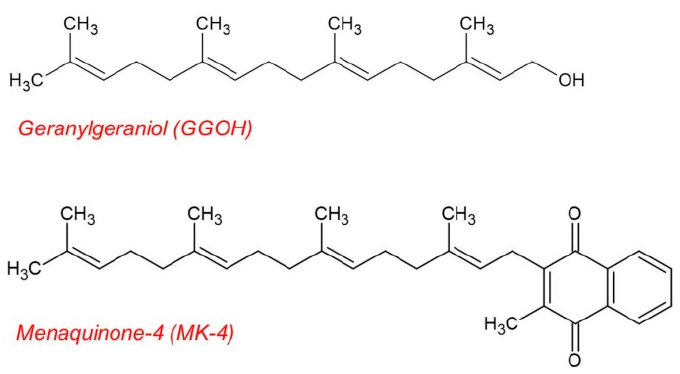
Figure 1. Chemical structure of geranylgeraniol (GGOH) and menaquinone-4 (MK-4). GGOH has a chemical structure that is similar to that of the side chain of MK-4, a vitamin K 2